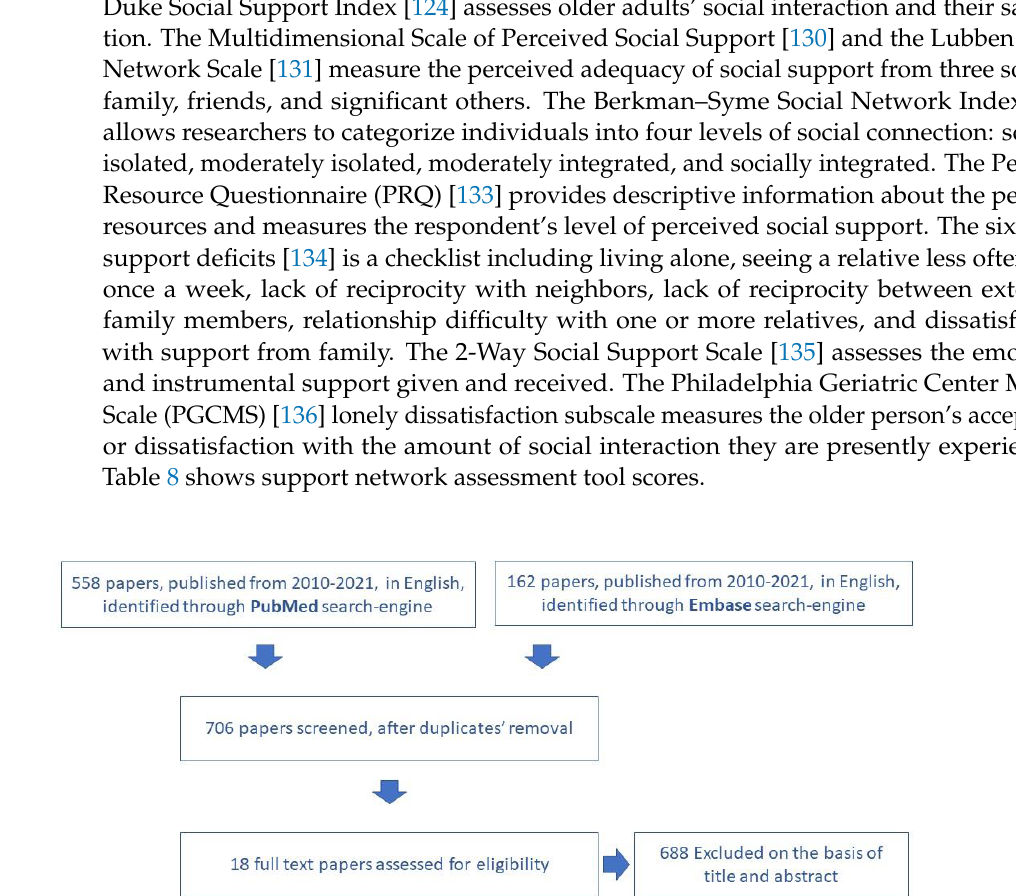
16 of 33 Table 7. Loneliness assessment tools scores.